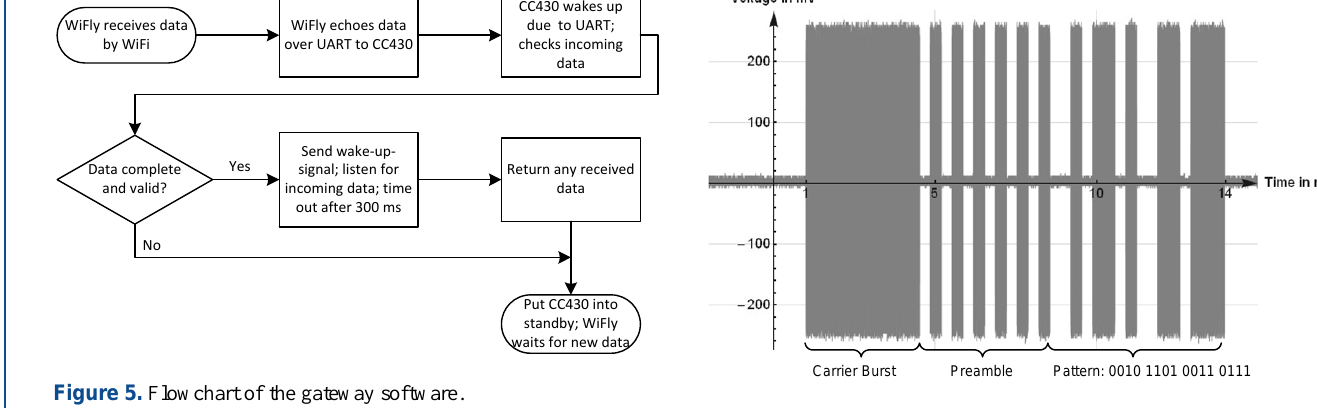
Figure 7. Expected wake-up signal by the sensor